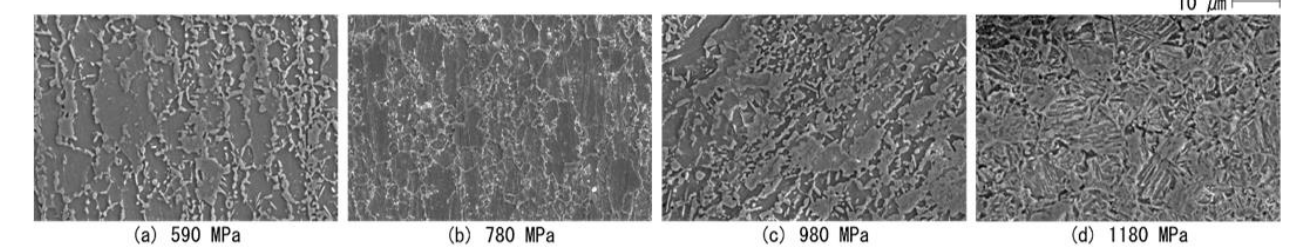
Figure 5. Microstructures observed by scanning electron microscopy: ( a ) 590 MPa steel sheet; ( b ) 780 MPa steel sheet; ( c ) 980 MPa steel sheet; and ( d ) 1180 MPa steel sheet.